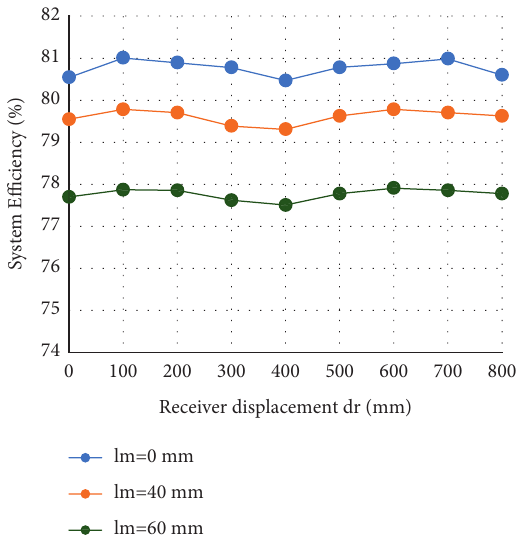
Figure 13: The system efficiency